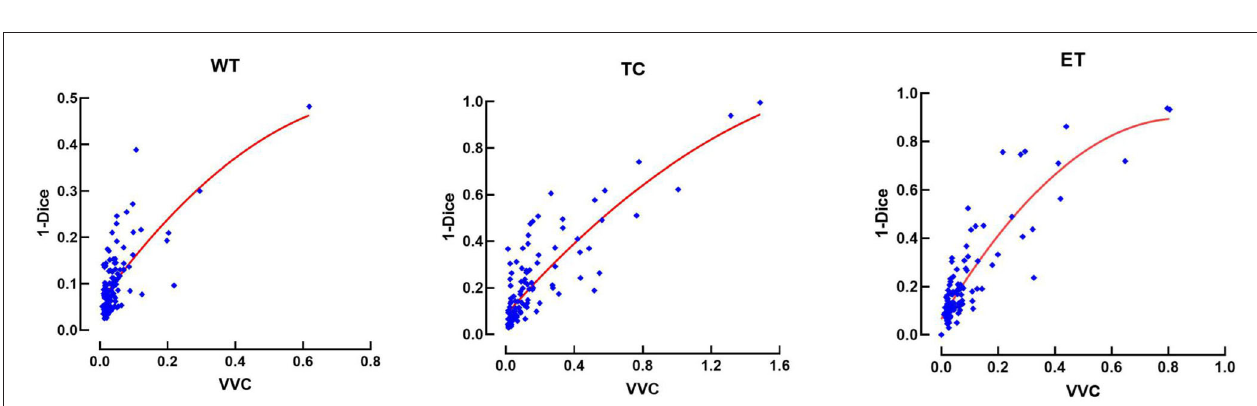
FIGURE 8 | Error (1-Dice) as a function of volume variation coefficient (VVC) for the BraTS 2019 validation set. WT, whole tumor; TC, tumor core; ET, enhancing tumor.